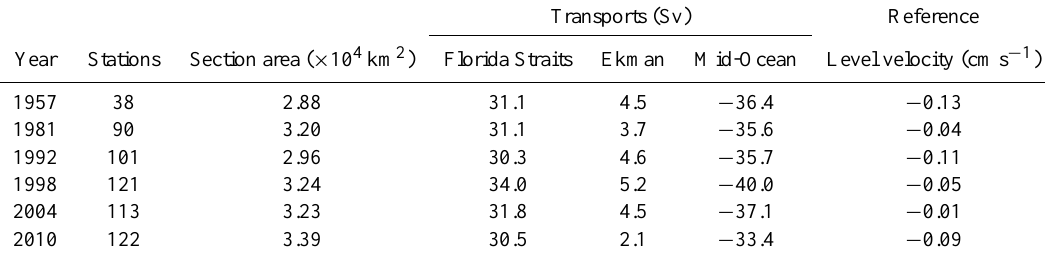
Table 1. Flow compensation components for each of the six hydrographic sections at 25 ◦ N (following Longworth, 2007). Stations refers to the number of CTD profiles made in the mid-ocean (i.e., east of the Bahamas) amounting to a section area as shown. Transports refer to annual average northward Florida Straits and Ekman transports and the southward mid-ocean transport required to maintain section mass balance (accounting for 0.8Sv of Bering Straits inflow to the North Atlantic). The final column gives the adjustment made to geostrophic mid-ocean reference level velocities to satisfy mass